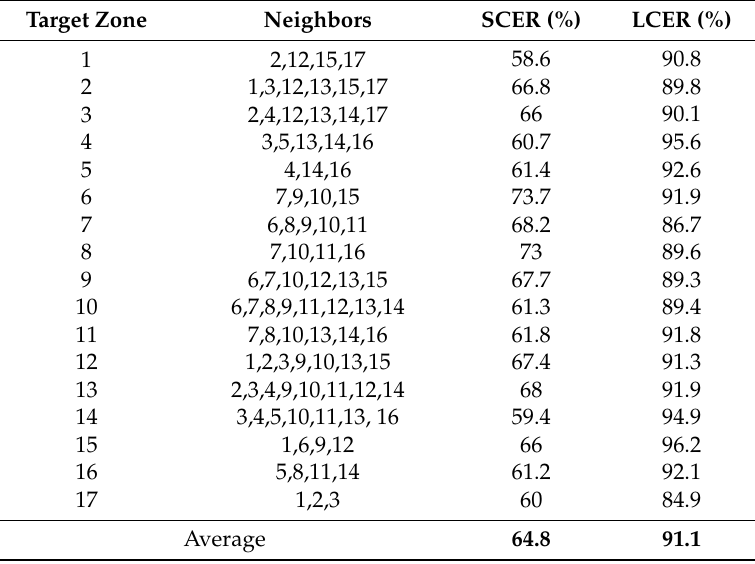
Table 8. SCER and LCER of scheme 2 with PCCR